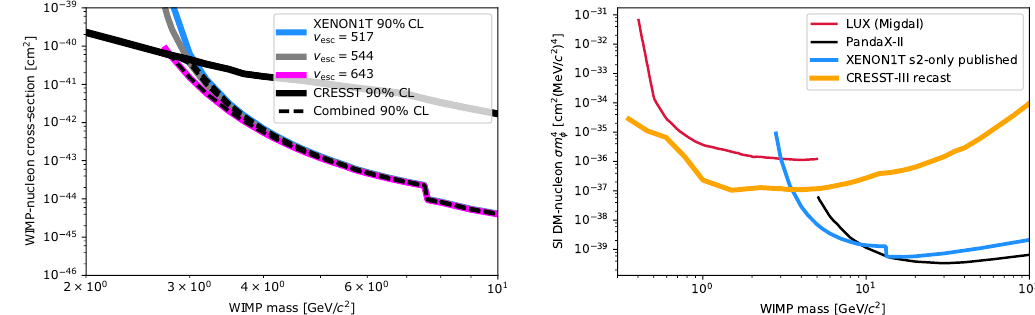
Figure 14: (Left) Constraints on the spin-independent WIMP-nucleon cross section using CRESST-III [ 157 ] and XENON1T ionization-only [ 159 ] data, altering the as- sumption on the Milky Way escape velocity v . Results from CRESST-III (black), esc with a lower energy threshold are approximately constant, while the higher energy threshold means the XENON1T limit is weakened with a lower escape velocity. The dashed black line shows a combined result. (Right) Spin-independent WIMP-nucleon cross sections in the case of a light mediator mass. The CRESST-III result has be de- termined according to Ref. [ 159 ] making use of the data public release, LUX results are presented in Ref. [ 161 ] , PandaX-II in Ref. [ 162 ]